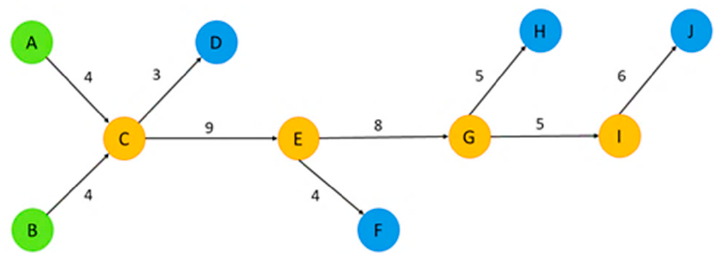
Figure 1. SPLC weight calculation.